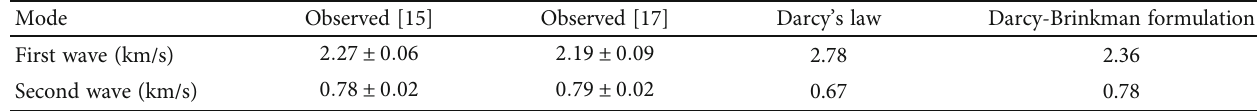
Table 1: Comparison of calculated and observed wave velocities.